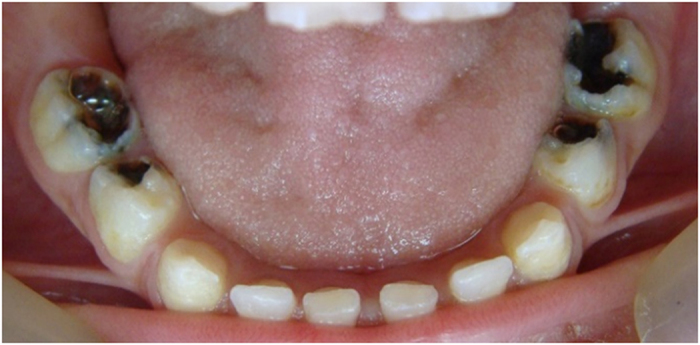
Pre-operative photo.